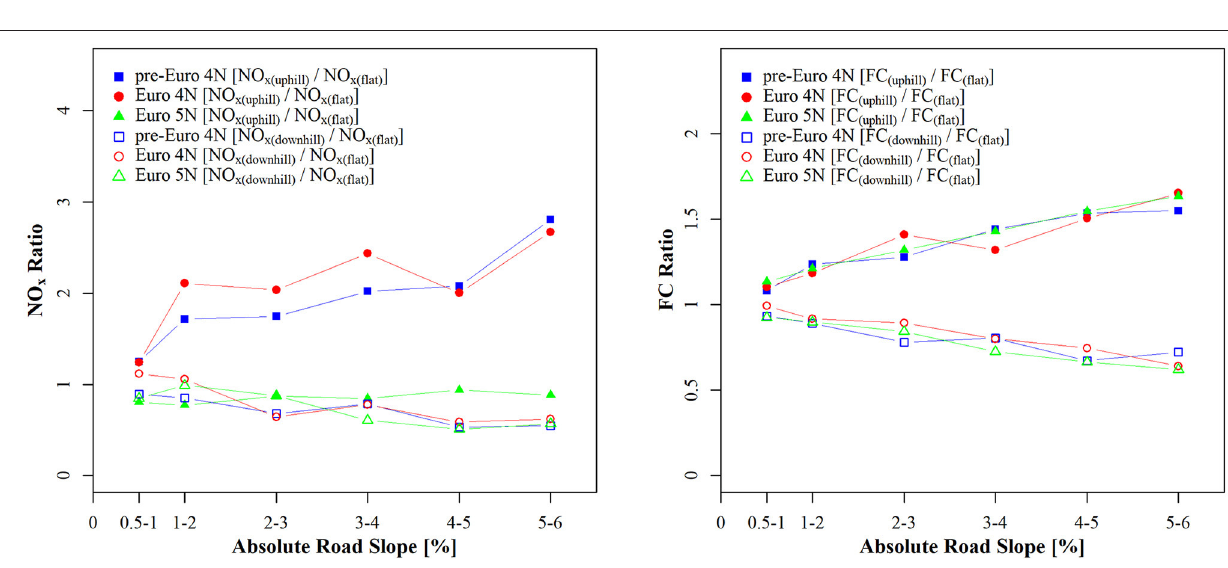
higher than in flat and downhill roads, respectively, while the corresponding FC ratios are 1.6 and 2.7, respectively. The error- bars reveal lower uncertainty in flat and downhill driving than in uphill road slope for NO x , while uncertainty for FC is overall much